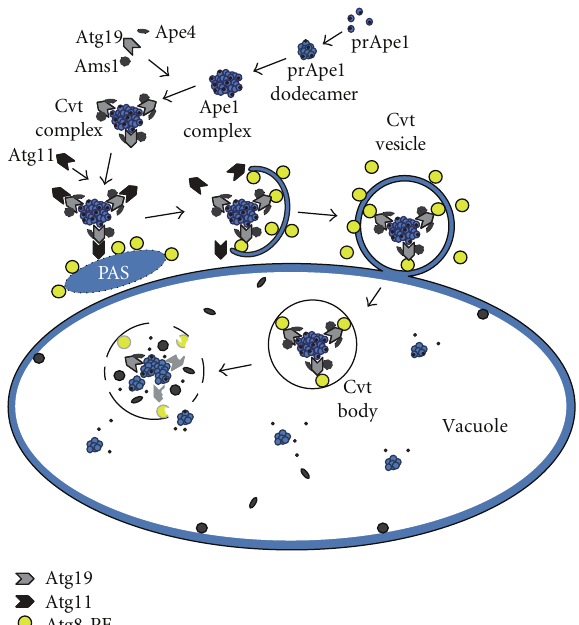
Figure 1: Overview of the Cvt pathway. (1) Formation of the Cvt complex: Precursor Ape1 forms a dodecamer. Multiple dodecamers assemble into an Ape1 complex. The Ape1 complex binds Atg19 via the prApe1 propeptide to form the Cvt complex. Other Cvt cargo, including Ams1 and Ape4, bind Atg19 at distinct domains. (2) Movement to the PAS: Atg19 binds the sca ff old protein Atg11, and the Cvt complex moves to the PAS. (3) Formation of the Cvt vesicle: Atg19 binds Atg8–PE, which drives the sequestration of the Cvt complex by the double-membrane phagophore. (4) Fusion of the Cvt vesicle with the vacuole: After completion of the Cvt vesicle, the outer membrane fuses with the vacuole, releasing the single membrane Cvt body into the lumen. The Cvt body is broken down by the Atg15 lipase, allowing access to vacuolar hydrolases. Atg19 and Atg8 are degraded. The propeptide of prApe1 is removed and the enzyme becomes